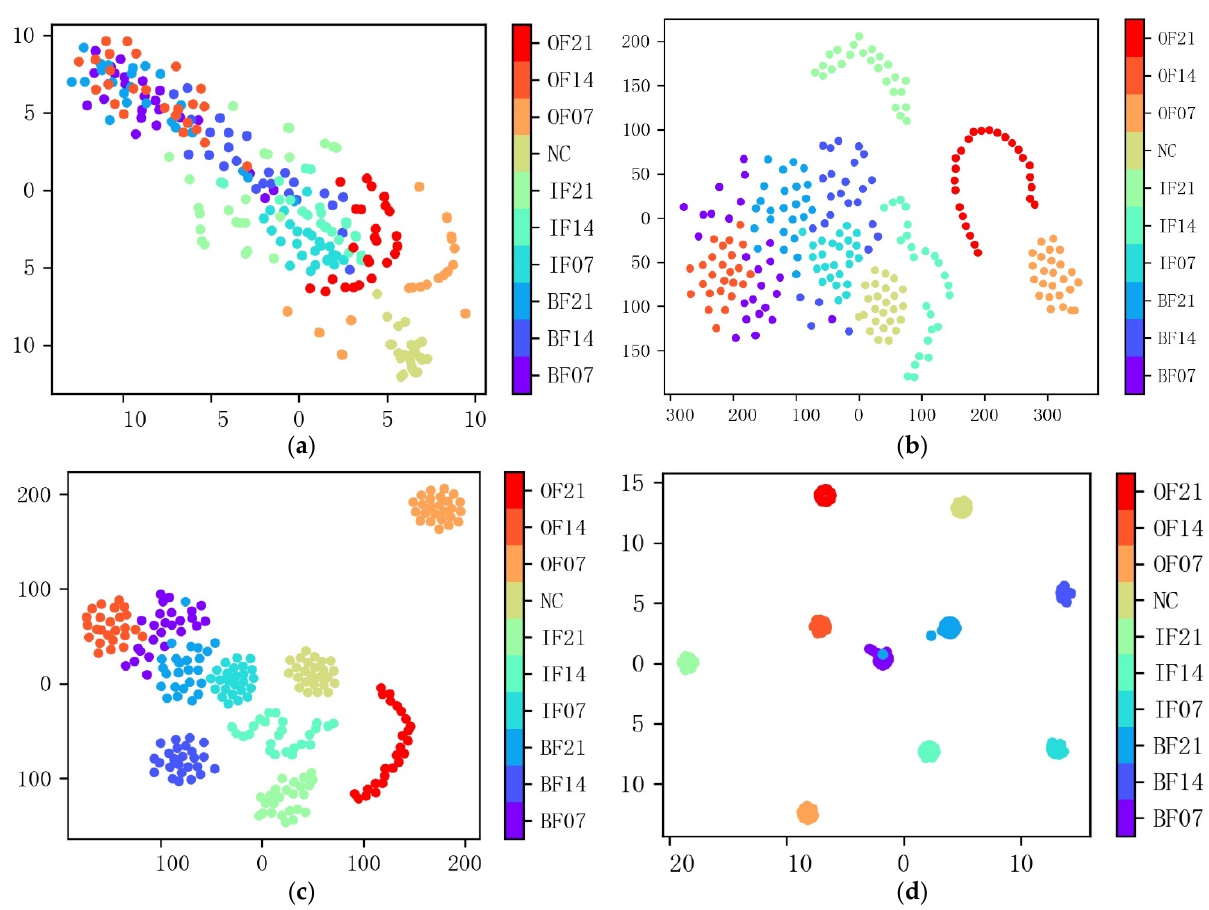
Figure 9. Feature visualization of different layers of the proposed MTF-ResNet. ( a ) First convolu- tional layer; ( b ) 13th convolutional layer; ( c ) 23rd convolutional layer; ( d ) fully connected layer.